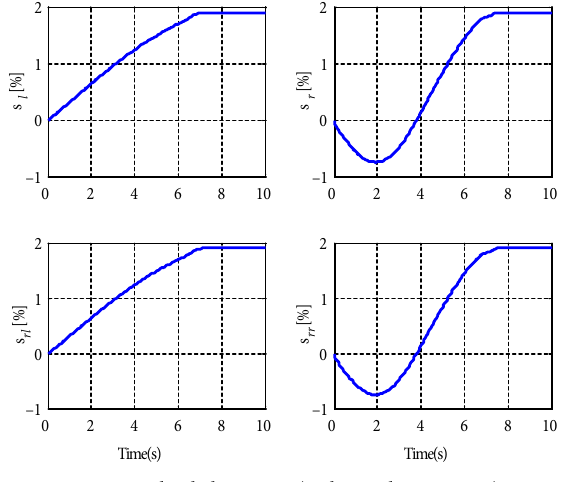
Fig. 14. Wheel slip ratios (right-angle turn case)